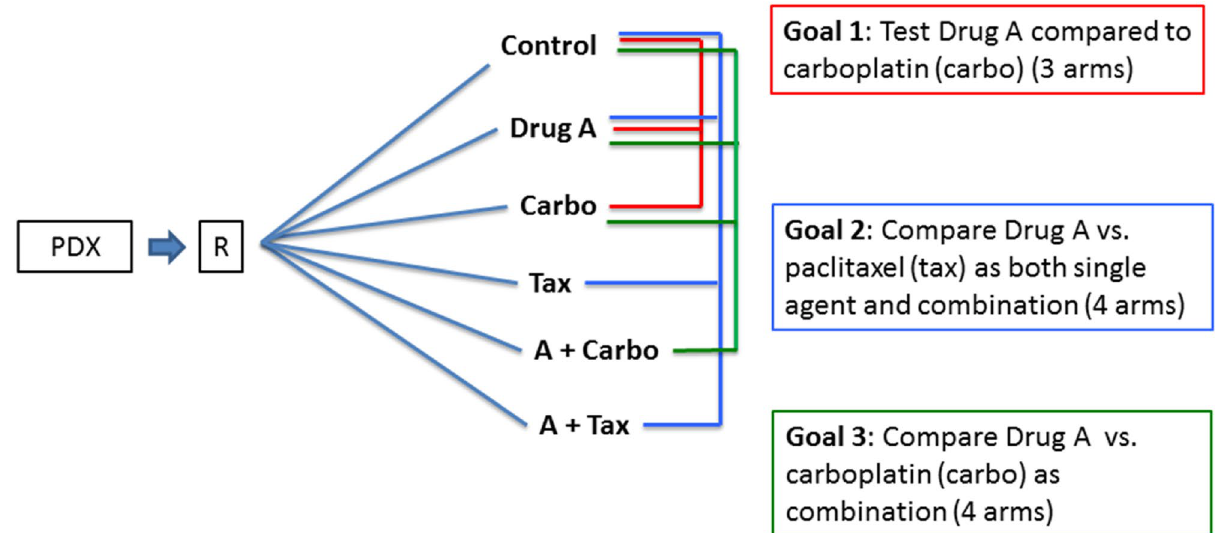
Figure 5. Experimental design. A series of three sequential studies was proposed to evaluate the goals stated in the colored boxes. Within a given PDX model, mice were to be randomized to the arms indicated, where the line color reflects the corresponding study goal. The first study goal used three drug arms to test efficacy of Drug A compared to carboplatin (goal 1, red). The second study goal used four drug arms to test efficacy of Drug A as a single agent and in combination with paclitaxel versus paclitaxel alone (goal 2, blue). The third study goal used four drug arms to test Drug A in combination with carboplatin (goal 3, green). The three studies called for 8 mice per arm in each of 11 arms, or 88 mice per PDX model. After discussion with the study team, we proposed a single six-arm study to be performed within each PDX model, with all three study goals utilizing the same control and Drug A arms, using 8 mice/arm * 6 drug arms * = 48 mice per PDX model. This represented a 45% reduction in mice required. Each study was to be performed in multiple PDX models, randomly drawn from platinum sensitive or platinum resistant phenotypes, so that effects could be compared between the two